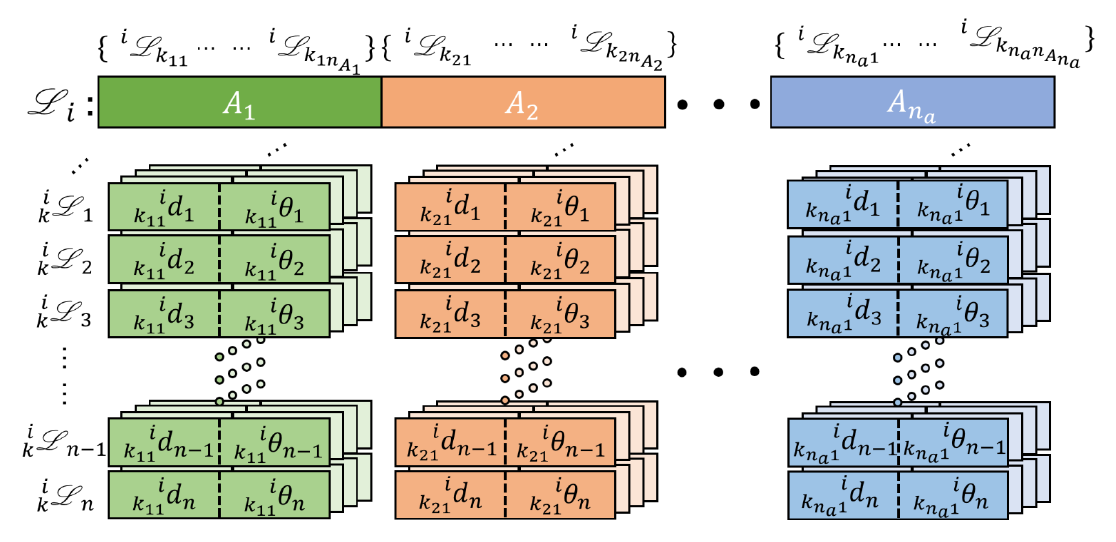
Figure 5. Third-order tensor structure of location descriptor L i , which is divided into X